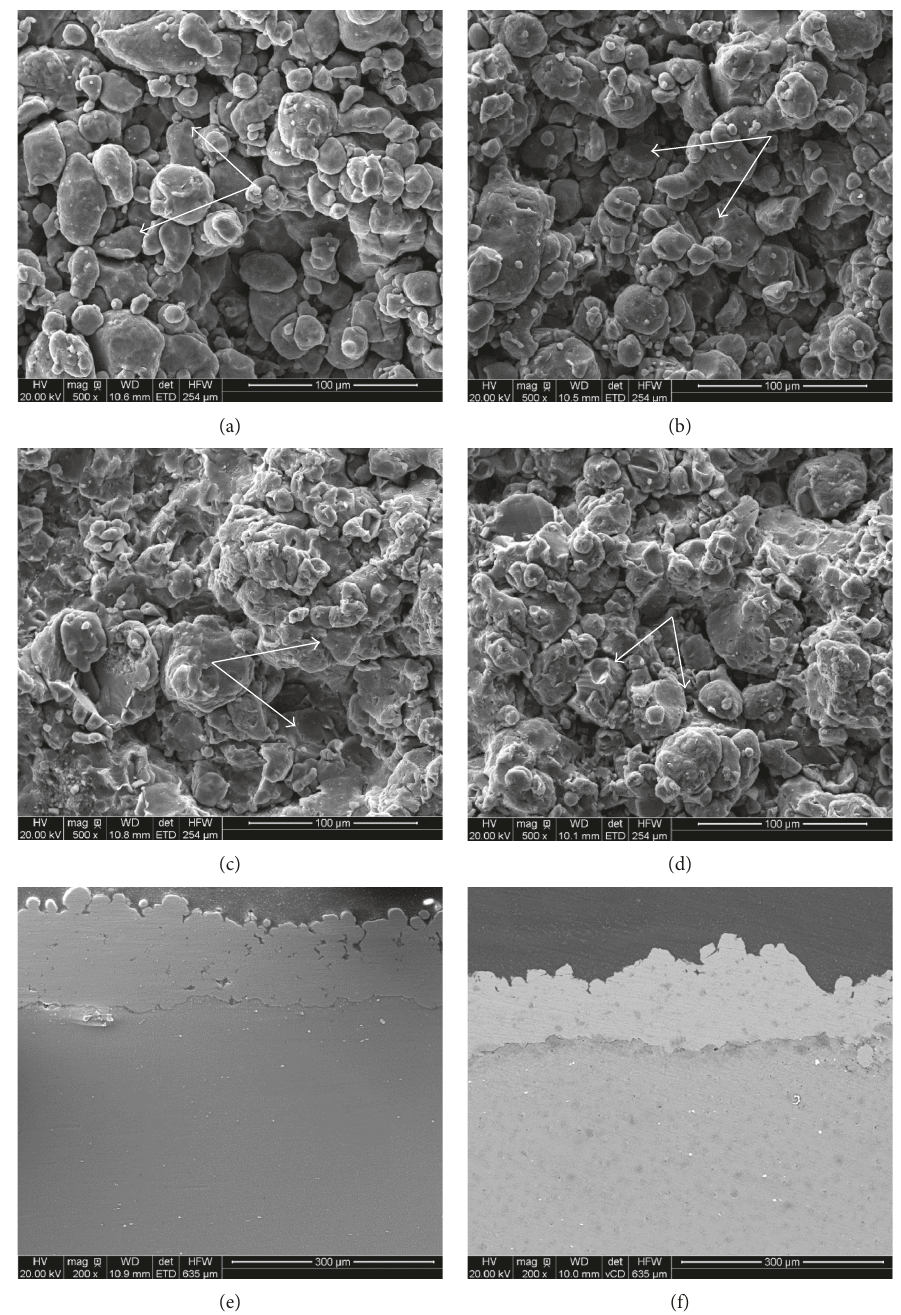
Figure 1: The surface morphologies of the as-sprayed coating 0 (a), coating 10 (b), coating 20 (c), and coating 40 (d) and the cross-sectional morphologies of coating 0 (e) and the composite coating 40 (f).